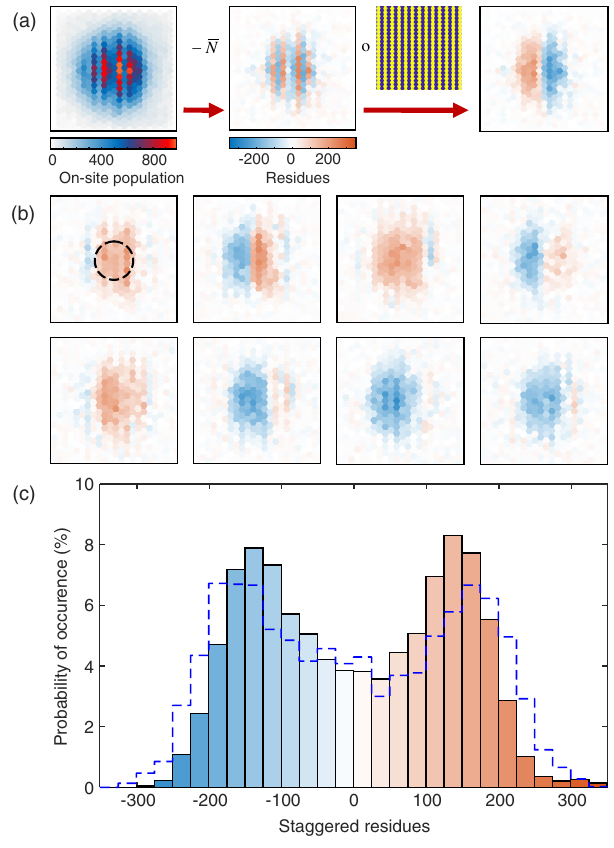
FIG. 2. Spontaneous symmetry breaking. (a) The local density- wave order is quantified by calculating the residues after subtracting the mean density of about 130 identically prepared clouds. Multiplying by a staggering of fixed phase yields the staggered residues, which act as domain identifier. (b) Staggered residues for typical individual images with Δ ¼ h × 1 . 4 kHz energy offset and 60 ms hold time illustrating the spontaneous formation of domains in the density-wave order with typically one or two large domains. (c) Histogram of the staggered residues for all lattice sites within a region of interest [dashed circle of radius 3 sites in (b)]. The dashed line represents the histogram for T=J ¼ 250 and a peak density of a numerical simulation with k B 900 atoms per